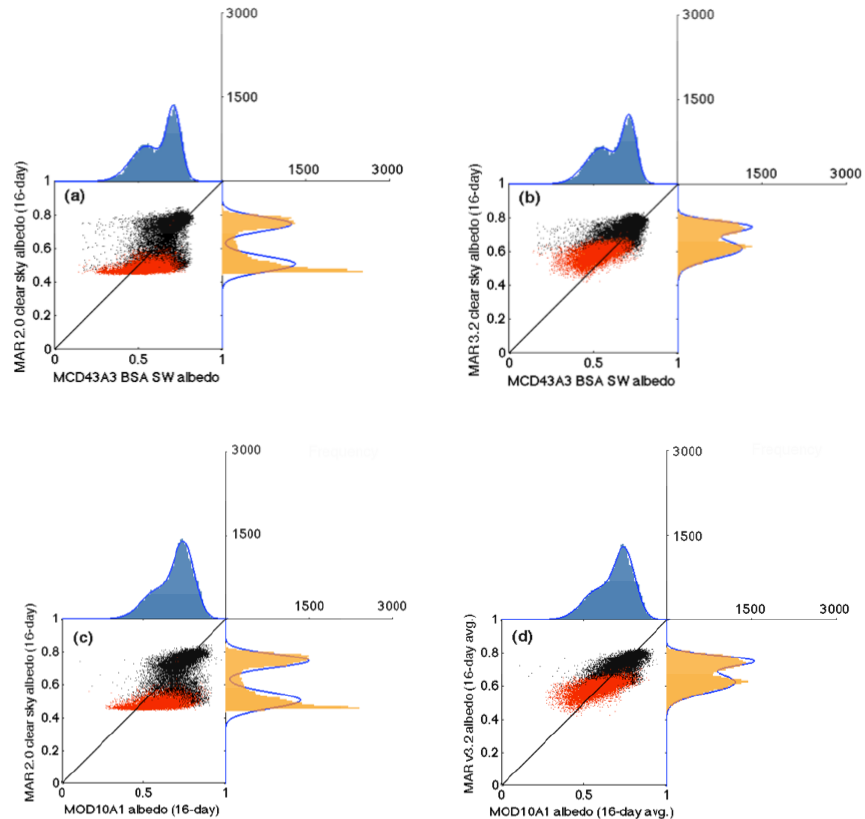
Figure 11. Scatter plots and histograms for JJA 2000–2012 albedo [unitless] within the MAR v3.2-defined GrIS ablation zone, for (a) MAR v2.0 clear-sky (16-day avg.) vs. MCD43A3 BSA SW. (b) The same as (a) , but for MAR v3.2. (c) The same as (a) but for MOD10A1 albedo (averaged to 16-day periods). (d) The same as (c) but for MAR v3.2. Points where there is snow or firn (surface snowpack density >830kgm − 3 ) for more than eight days of a 16 day period are shown in red. Light blue curves show the best fit to each distribution obtained using maximum likelihood estimation.